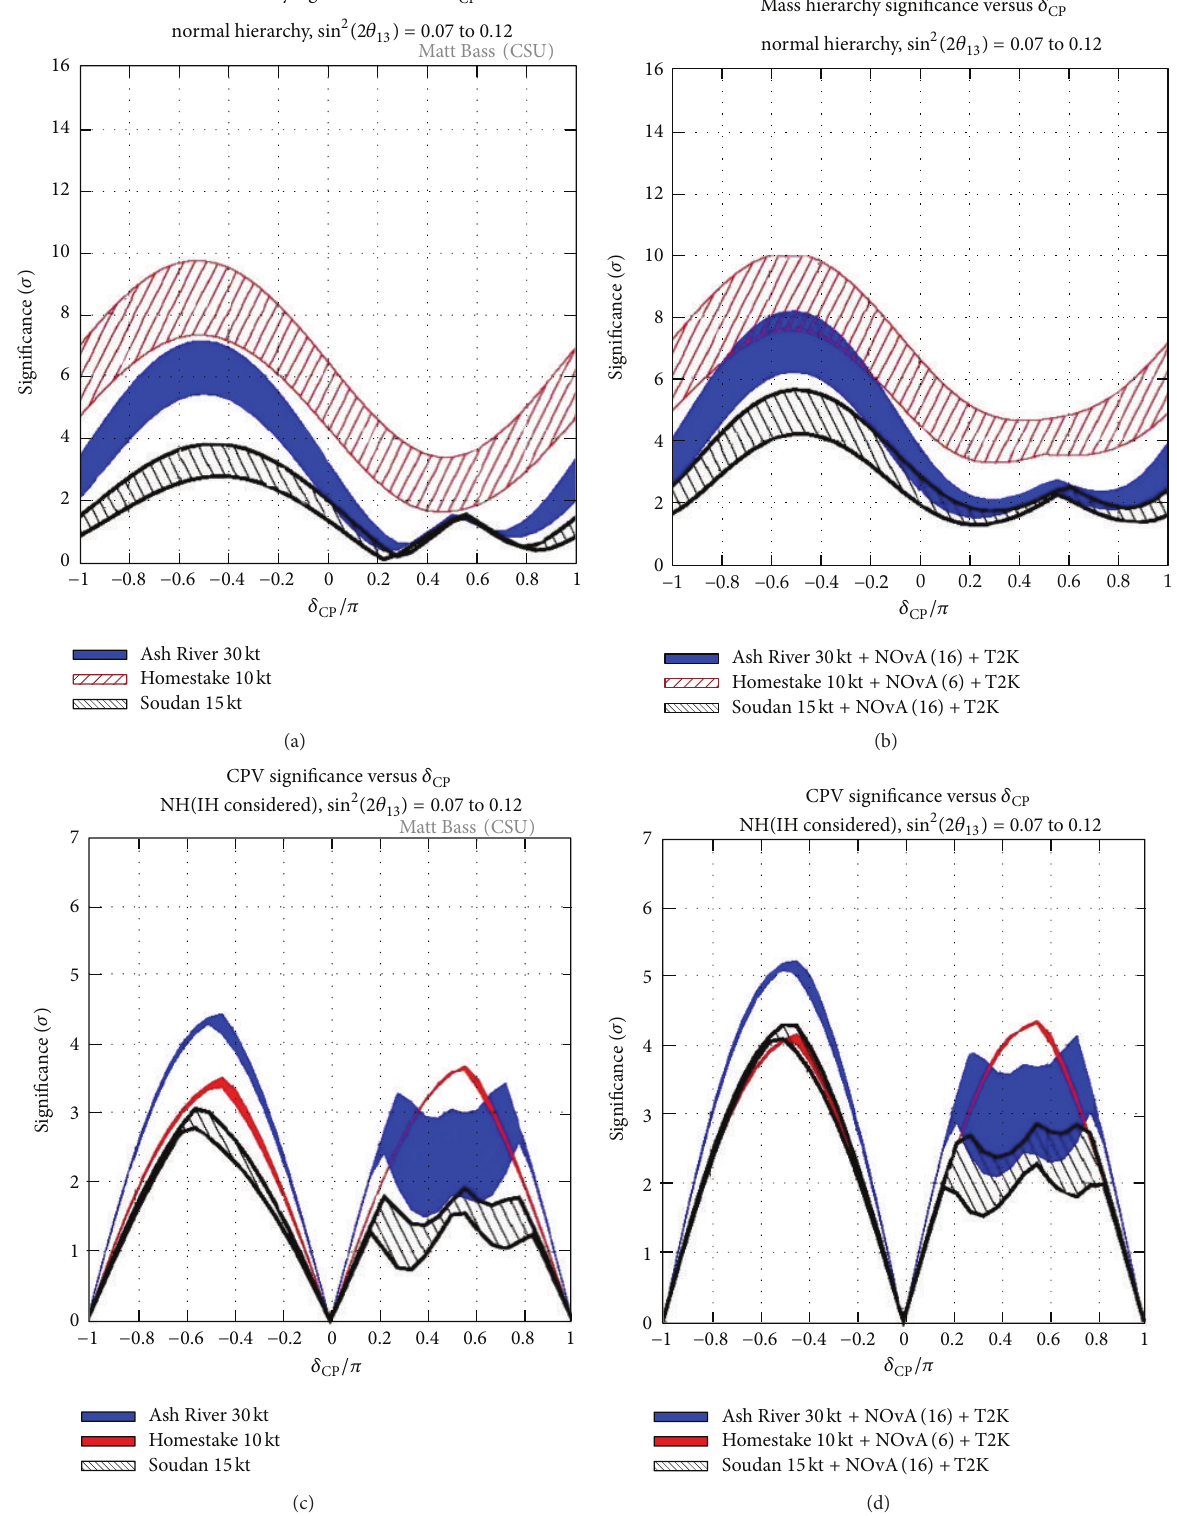
Figure 10: LBNE sensitivity to the mass hierarchy (upper plots) and CPV (lower plots) at 3𝜎 as a function of 𝛿 for the three reconfiguration options, as described in the text. The sensitivities are reported for the experiment alone (left) and when combined with NOvA for 3𝜈 + 3 𝜈 years and T2K. The Ash River and Soudan options use the NuMI beam line, and therefore additional 5𝜈 + 5 𝜈 years for NOvA are included, assuming that this detector will be kept in operation in parallel to the LAr detector. Figure taken from